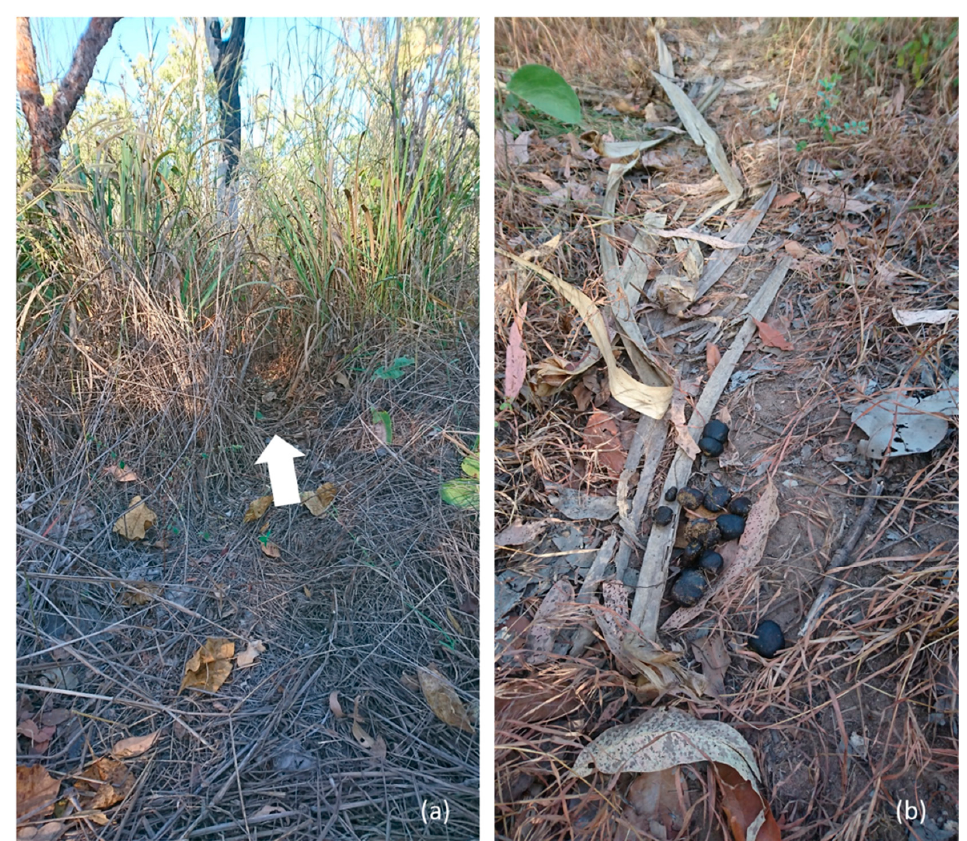
Figure 5. ( a ) Animal pathway (arrowed) through tropical savanna vegetation with over-arching vegetation below height of average person, ( b ) faecal deposit from wallaroos ( Osphranter spp.) deposited on pathway defined by their regular use (Images: D.B. Croft).